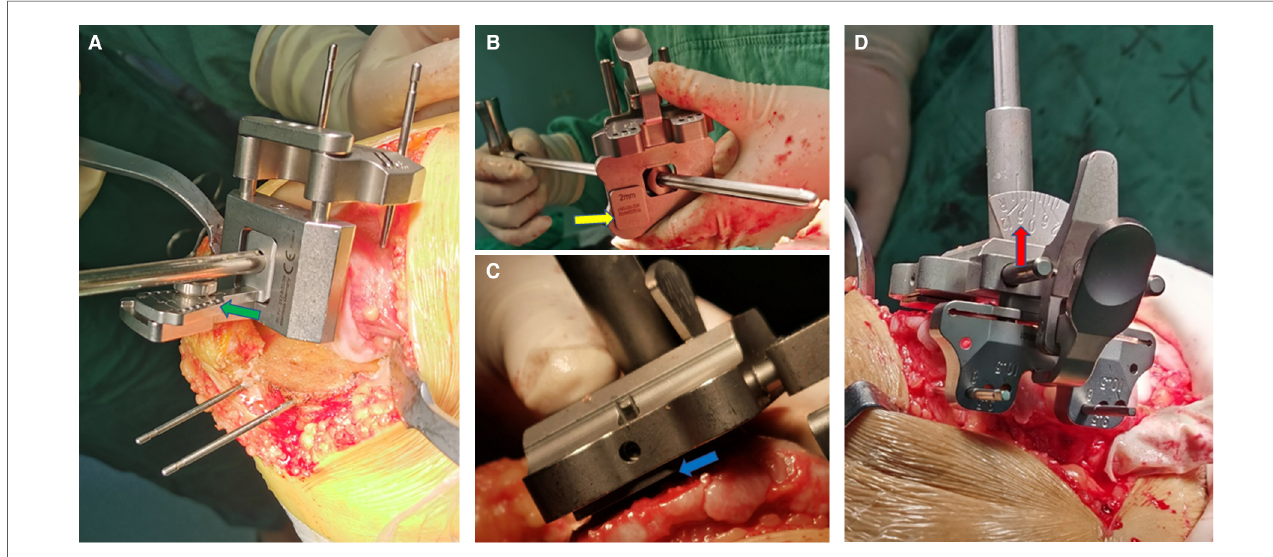
FIGURE 1 Placement and fi xation of the intramedullary positioning guide plate for distal femoral bone resection in coronal plane ( A for MA; B – D for KA). ( A ) The standard MA femoral intramedullary guided assembly, the valgus cutting angle was set at 6° with a chuck (green arrow). ( B ) An insert (yellow arrow) with 2 mm thickness prefabricated at the medial side on the distal femoral guide plate of the speci fi c KA instrument. ( C ) The distal femoral guide plate with the insert appressed against the worn distal articular surface of the medial condyle for compensation of cartilage wear (blue arrow); ( D ) The cutting block of the speci fi c KA instrument can be rotated freely up to ±12° on the coronal plane (red arrow), which is enough for varus-valgus adjustment according to native distal femur joint line.